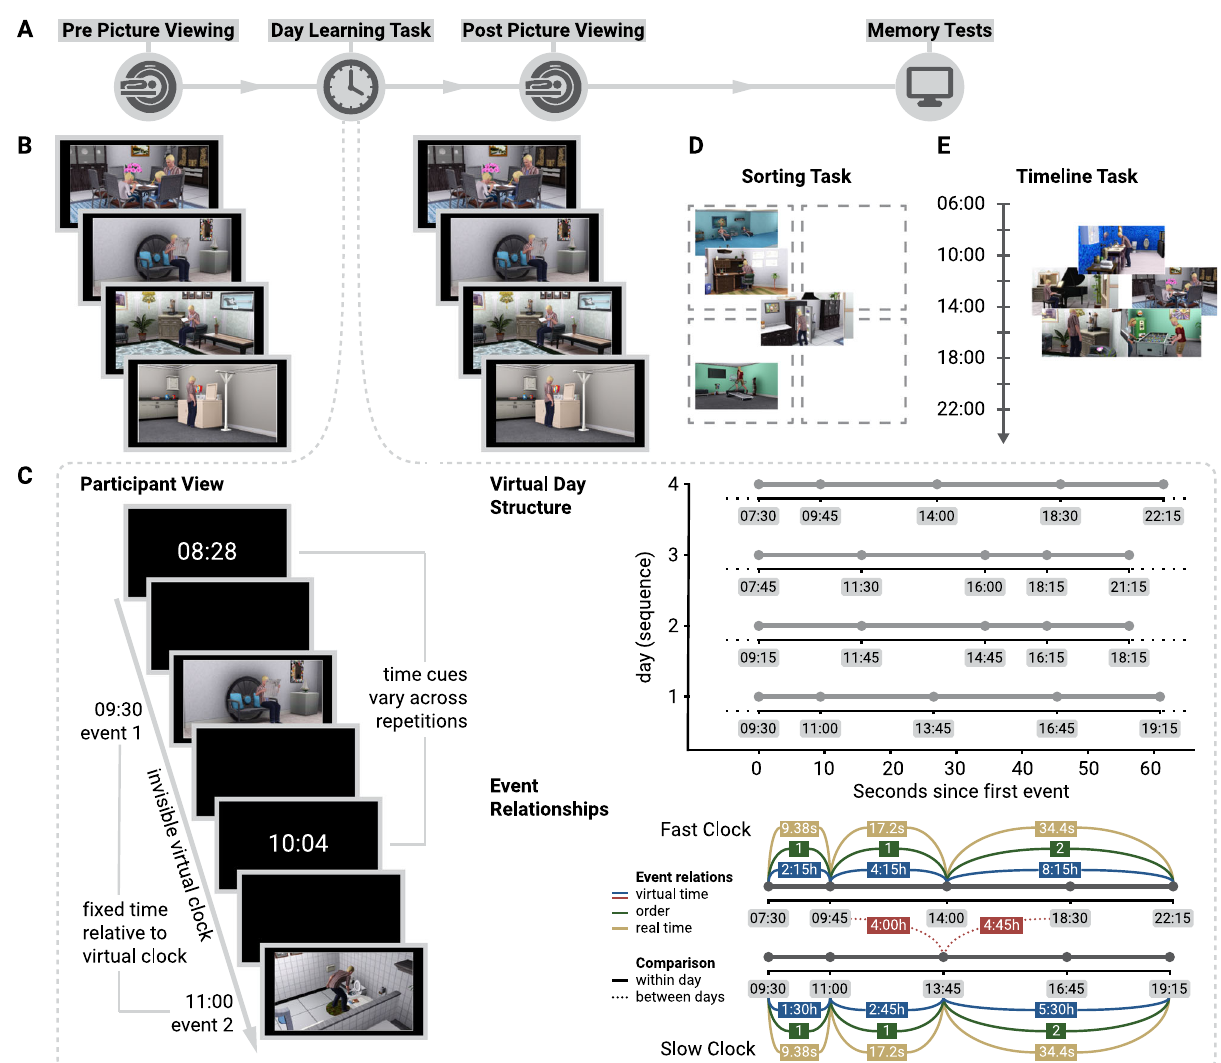
Fig. 1 Experimental design. A Overview of the experiment. B In the picture viewing tasks before and after learning, participants saw event images presented in the same random order and using identical stimulus timings. C The day learning task took place in between the picture viewing tasks. Participants learned four sequences (virtual days) of fi ve events each (Supplementary Fig. 1) and inferred when events took place relative to a virtual clock. Left: The virtual clock ran hidden in the background for each sequence and was revealed only once in between successive events. These time cues varied across repetitions of a sequence, but events occurred at consistent points in virtual time. The duration of blank screen periods varied according to the interval between the indicated time and the event time. Thus, participants had to mentally construct event times by combining their experience of elapsing real time with the time cues. Top right: The hidden clock ran at a fi xed speed relative to real time for a given sequence, but its speed varied between sequences (Supplementary Fig. 2). Bottom right: Different time metrics capture the temporal structure of the event sequences. Event relations can be quanti fi ed using temporal distances relative to the hidden clock (virtual time), sequence positions (order), and elapsed time in seconds (real time). While these metrics inevitably covary, they are partially dissociated by the clock speed manipulation. Virtual temporal distances can be quanti fi ed both within (solid lines) and across sequences (dotted lines). D , E Participants ’ memory of the sequences was tested in two tasks. In the sorting task ( D ), participants sorted the scenes according to the four different sequences. In the timeline task ( E ), participants positioned the fi ve event images of a given sequence next to a timeline to indicate constructed event times. B – E The Sims 3 and screenshots of it are licensed property of Electronic Arts, Inc. All rights are